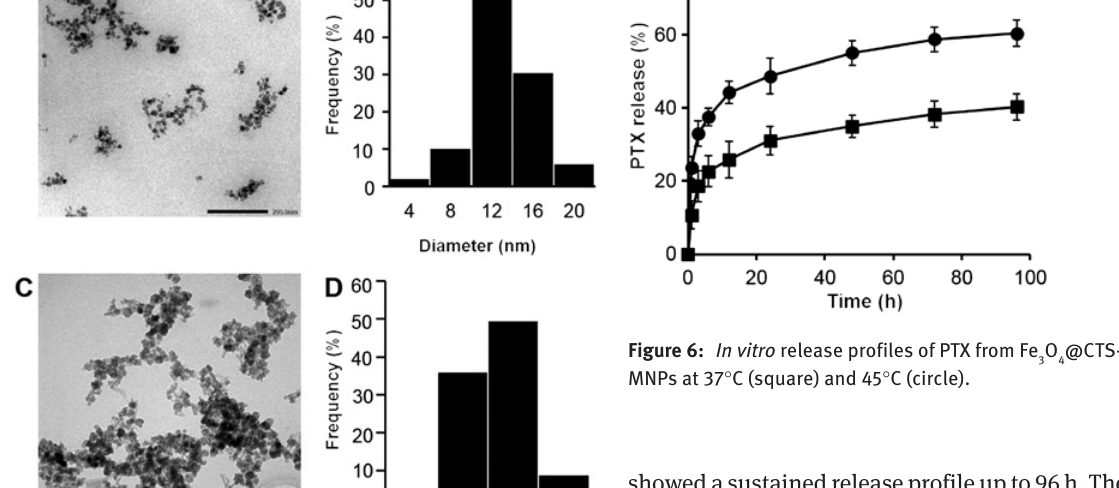
O @CTS-mPEG MNPs. 3 4